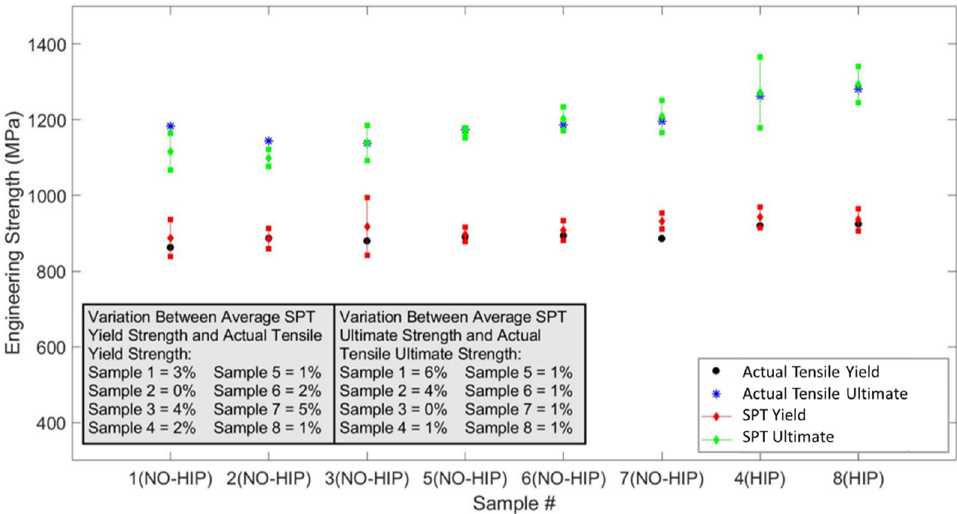
Figure 9. Yield strength and ultimate tensile strength (UTS) results from all SPTs showing average and standard deviations, along with the corresponding UTT measured yield strengths and UTS results.